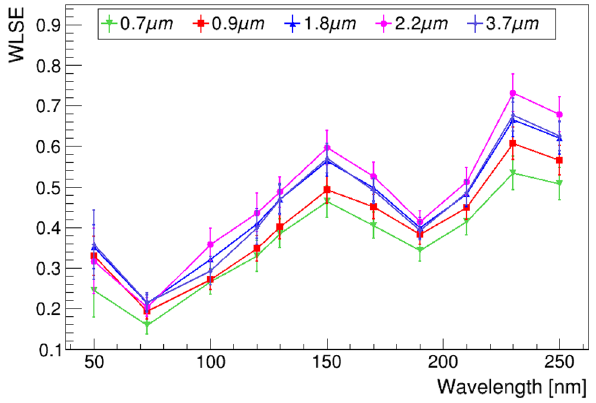
Fig. 16 Absolute WLSE efficiency for several samples of various thickness